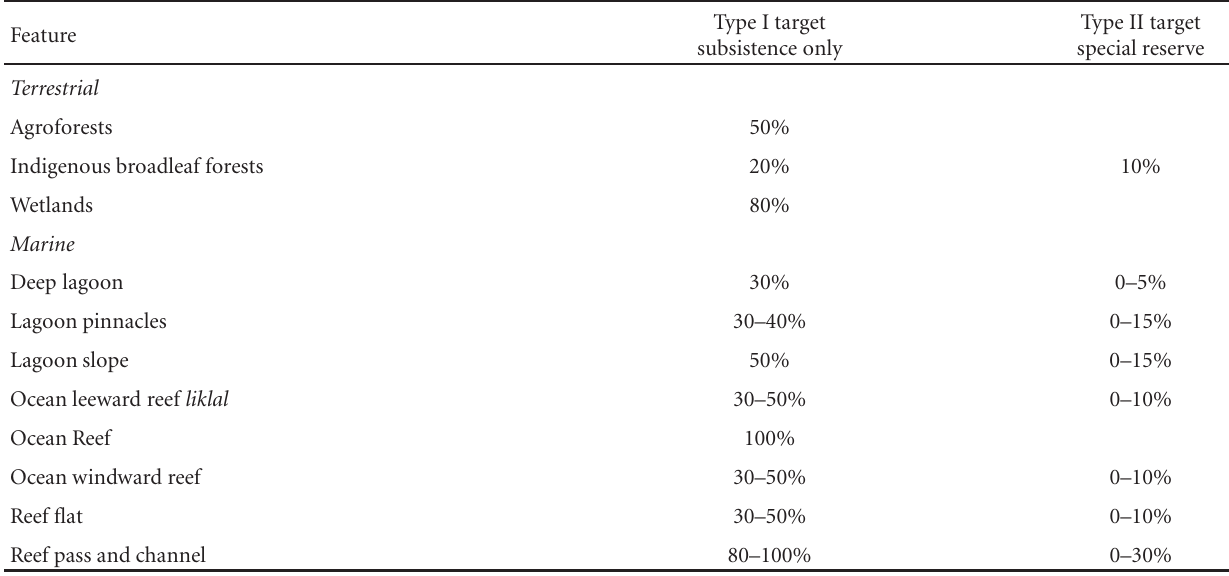
Table 2: Conservation features and targets in the Marshall